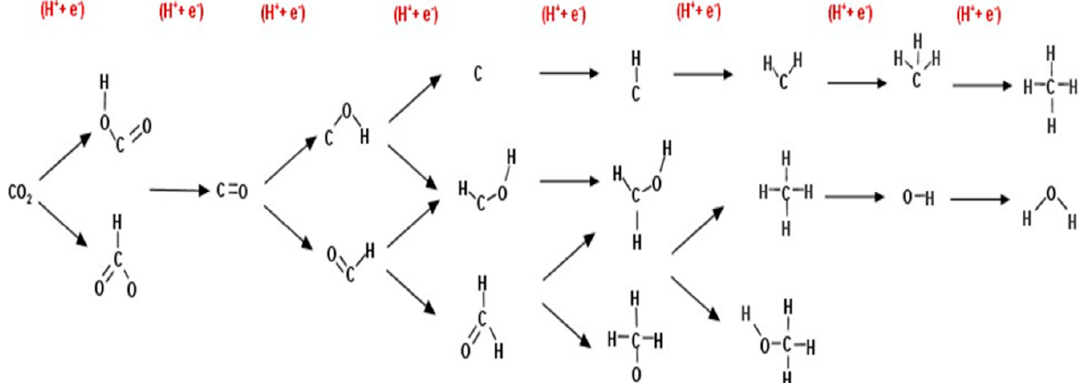
Figure 13. Possible reaction energy mechanisms for electrochemical reduction of CO 2 to CO, CH 4 , and CH 3 OH. OH, and H 2 O formed along the reaction pathways are omitted in the figure for clarity